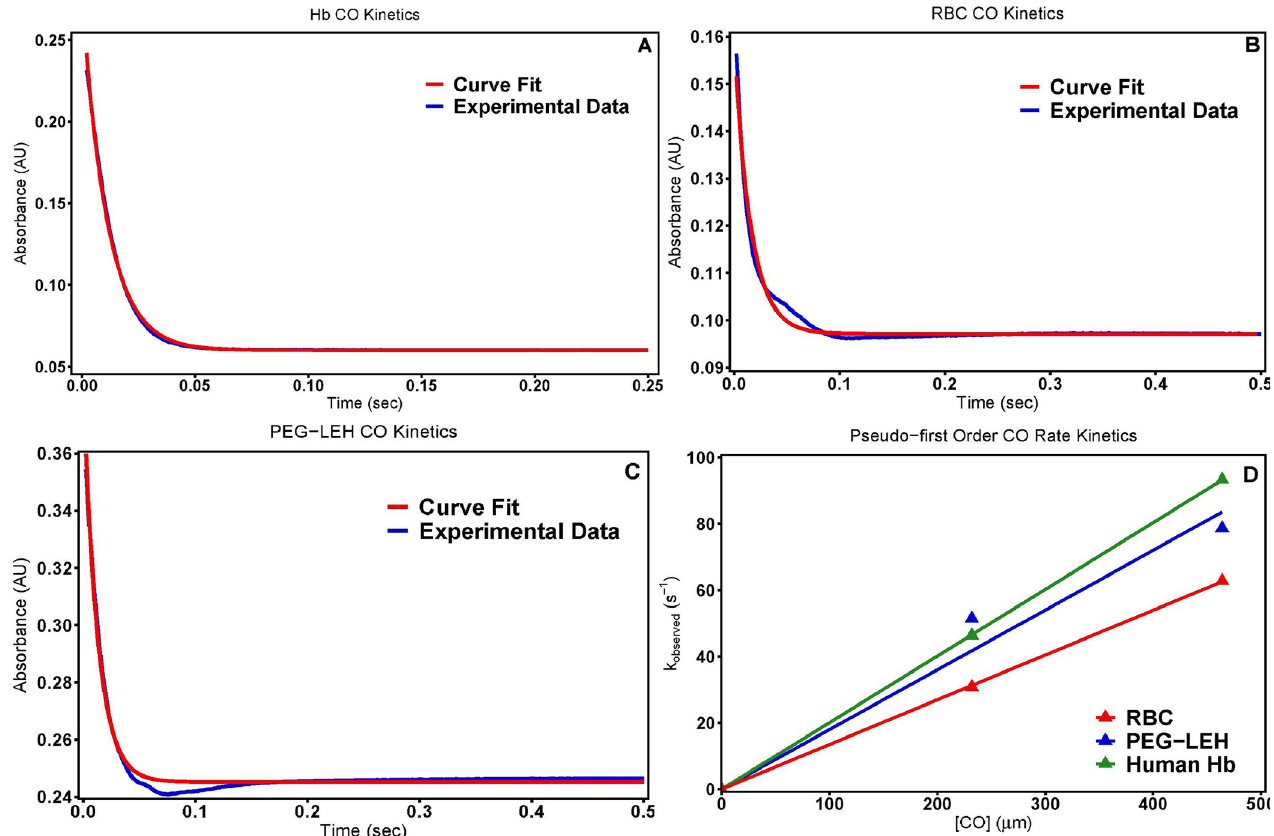
Fig 5. CO rate kinetics. Time courses for the CO (464 μ M) association reaction with deoxygenated (A) Hb, (B) RBCs, and (C) PEG-LEH nanoparticles. The CO association reaction was carried out in presence of 1.5 mg/mL sodium dithionite. The experimental data shows an average of 10–15 kinetic traces. The reaction was monitored at 437.5 nm and 20˚C. PBS was used as the reaction buffer. (D) Comparison of CO pseudo first order association rate constants for Hb, RBCs and PEG-LEH nanoparticles as a function of